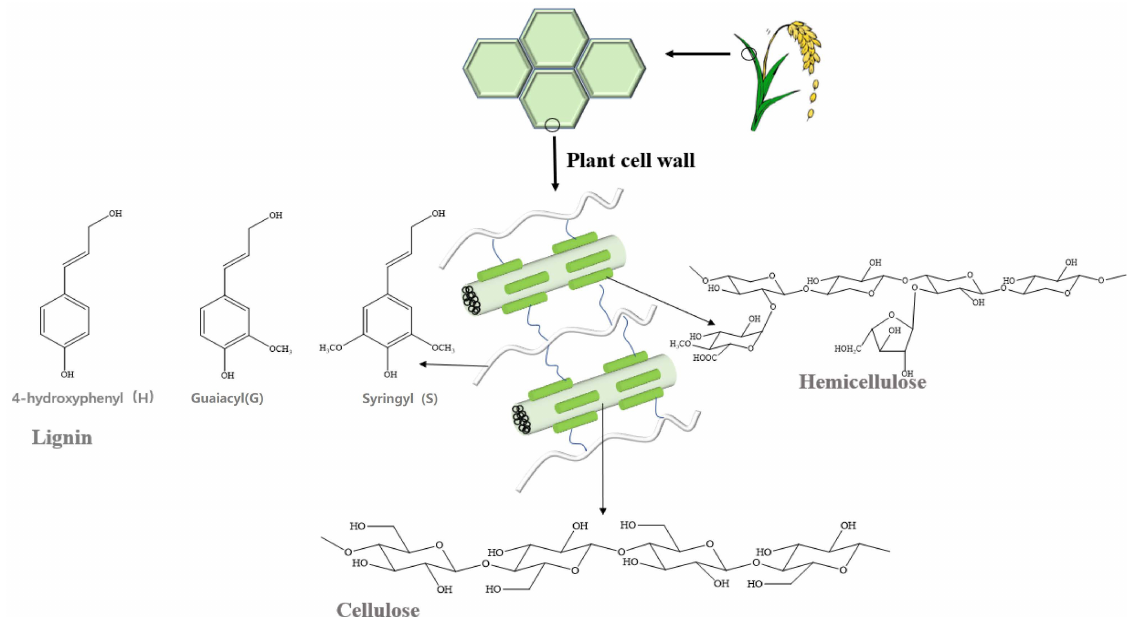
Figure 1. Micro-structure of straw